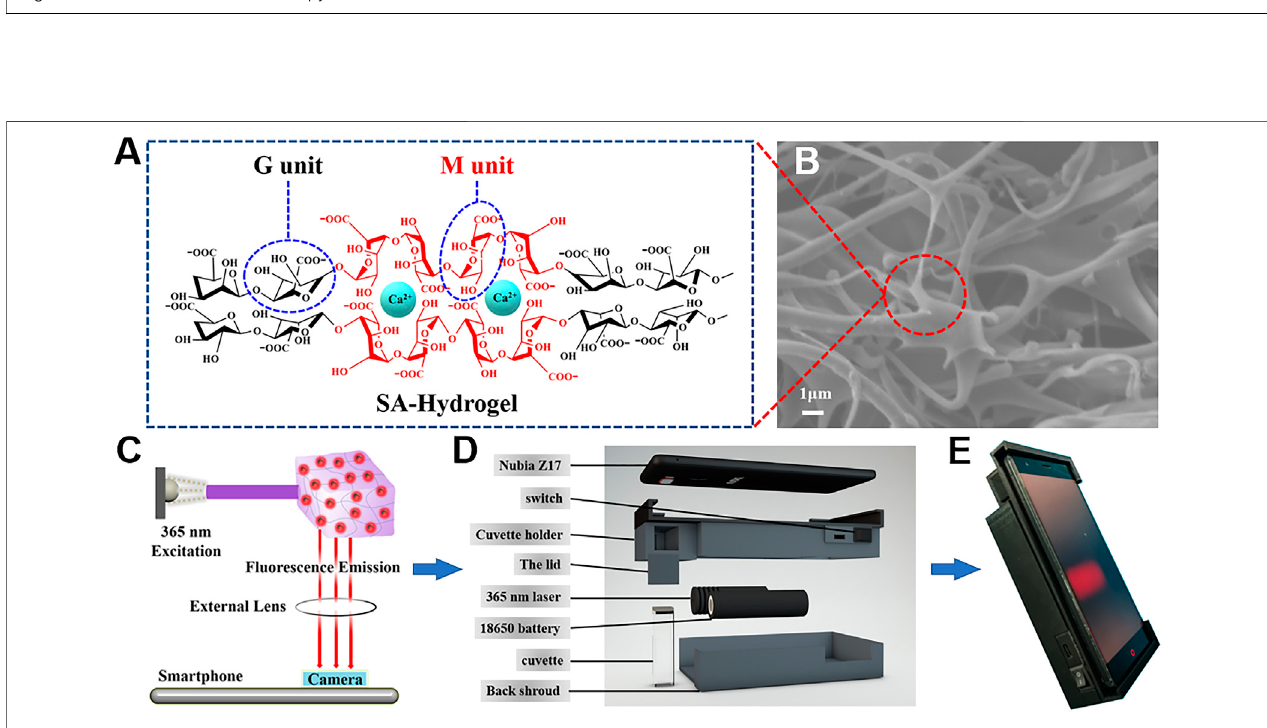
FIGURE3|(A) Illustrationofthe “ egg-box ” structure,containingtheGunitandMunit. (B) SEMimages ofSAhydrogels. (C) Optical routeofthedesigned portable device. (D) Design of the 3D-printed accessory. (E) Portable device for image acquisition.